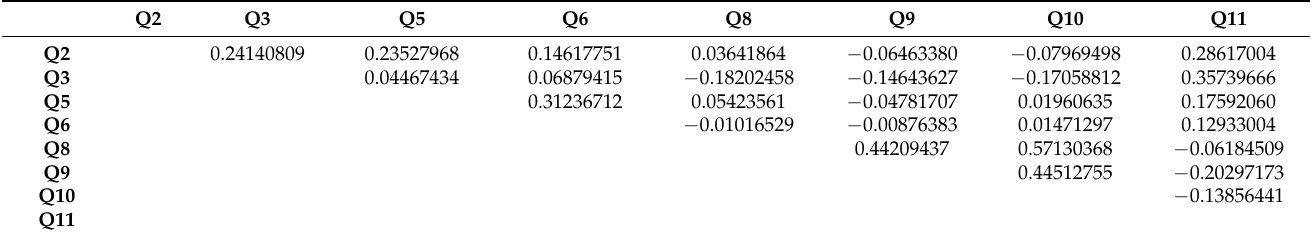
Table 5. Correlation coefficients between questions Q2, Q3, Q5, Q6, Q8, Q9, Q10 and Q11.